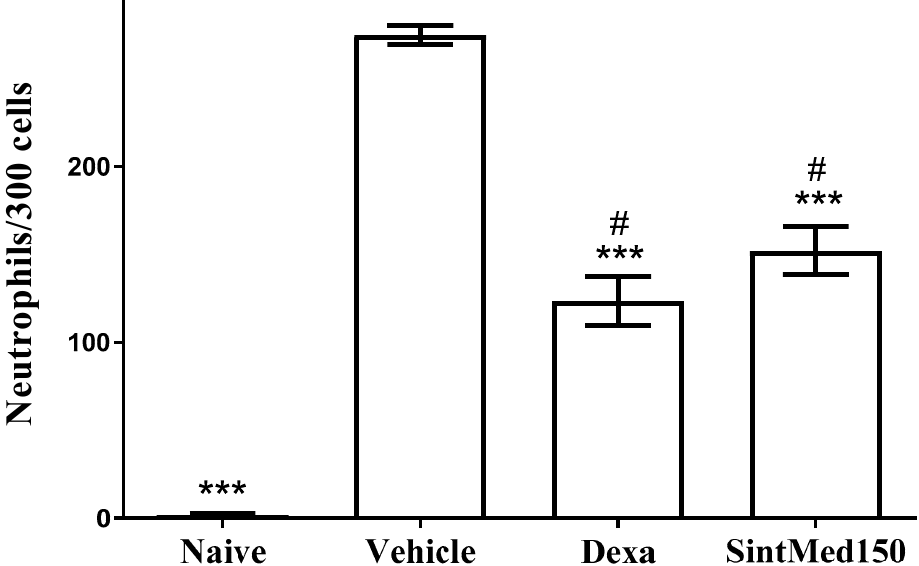
Figure 8. Effect of SintMed150 in a carrageenan-induced model of acute peritonitis. BALB/c mice ( n = 5/group) were treated with SintMed150 (100 mg/kg) or dexamethasone (Dexa; 25 mg/kg) or vehicle (solution containing 30% sorbitol, 10% Tween 80, and 60% saline) and challenged with 1% carrageenan solution. The naïve group consists of untreated and unchallenged animals. Values represent the means ± S.D. of six mice/group. *** p < 0.001 compared to the vehicle group; # p < 0.05 compared to naïve group.